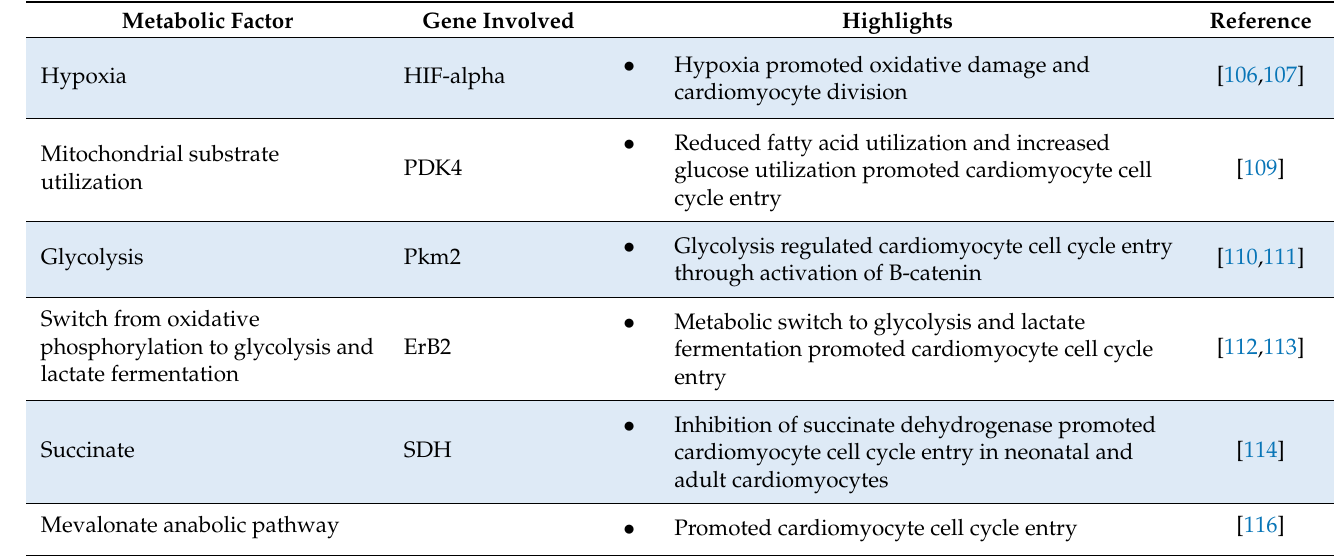
Table 5. Metabolic changes modulate cardiomyocyte cell cycle